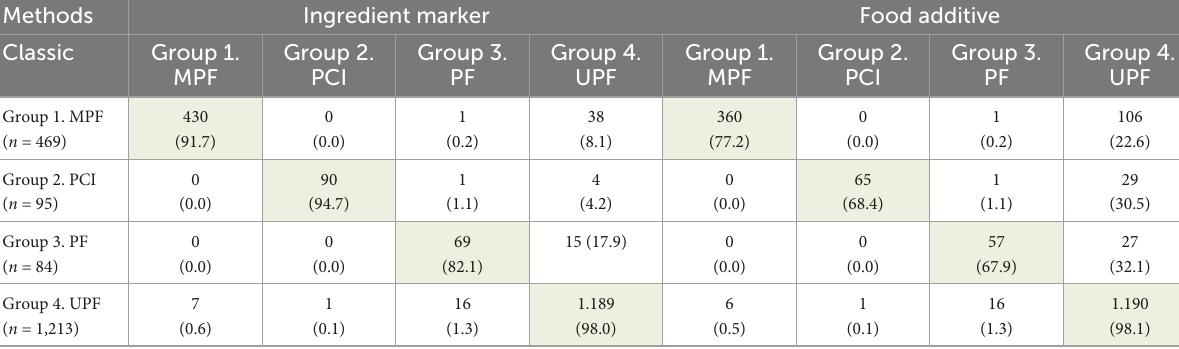
TABLE 2 Distribution ( n ; %) of NOVA food groups obtained in “classic method” according to “ingredient marker” and “food additive” methods in foods and beverages ( n = 1,861).